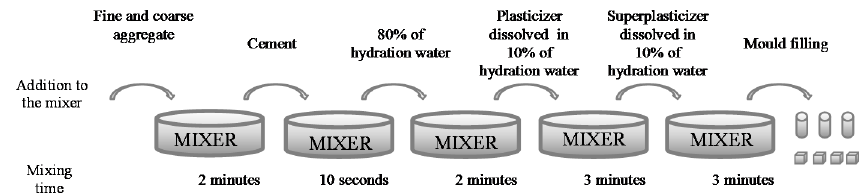
Figure 2. Mixing process diagram.